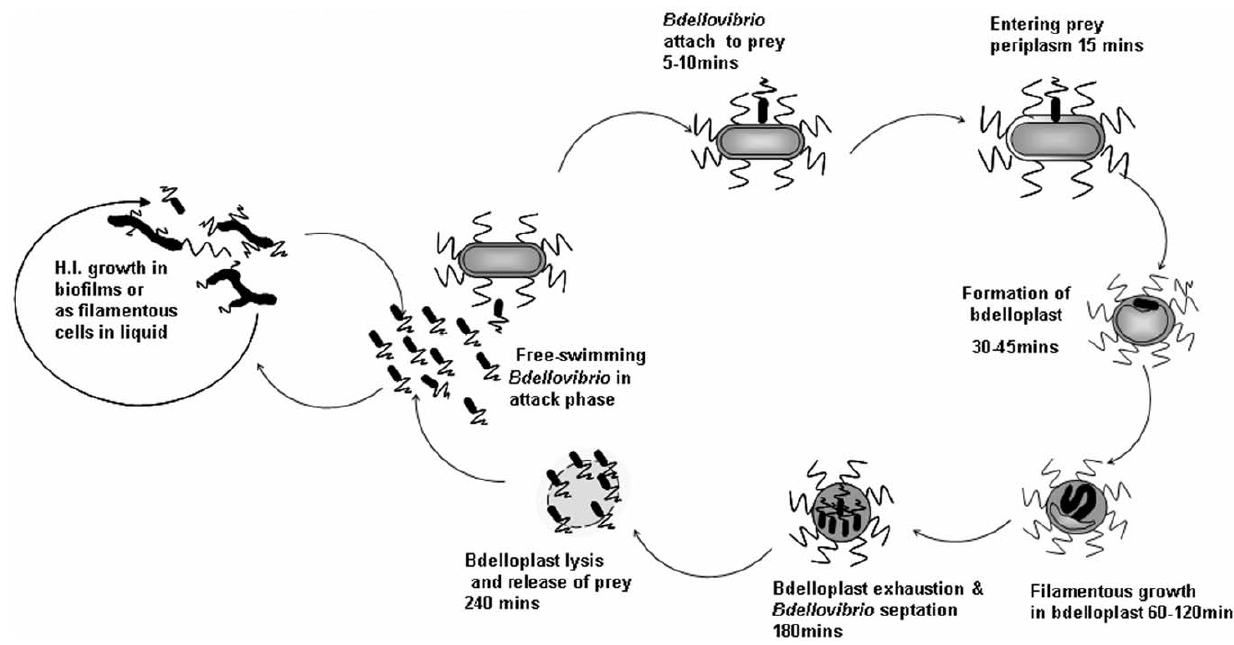
Figure 1. Predatory and HI growth cycles of Bdellovibrio . Attack-phase cells invading E. coli prey undergo a predatory growth cycle and replicate, being released some 4 hours later. Timing of the predatory cycle events are shown, including the 30 minute predation stage when Bdellovibrio are in the bdelloplast. Axenic growth of pleiomorphic sessile HI cells occurs on protein-rich media for cells derived from attack-phase populations.